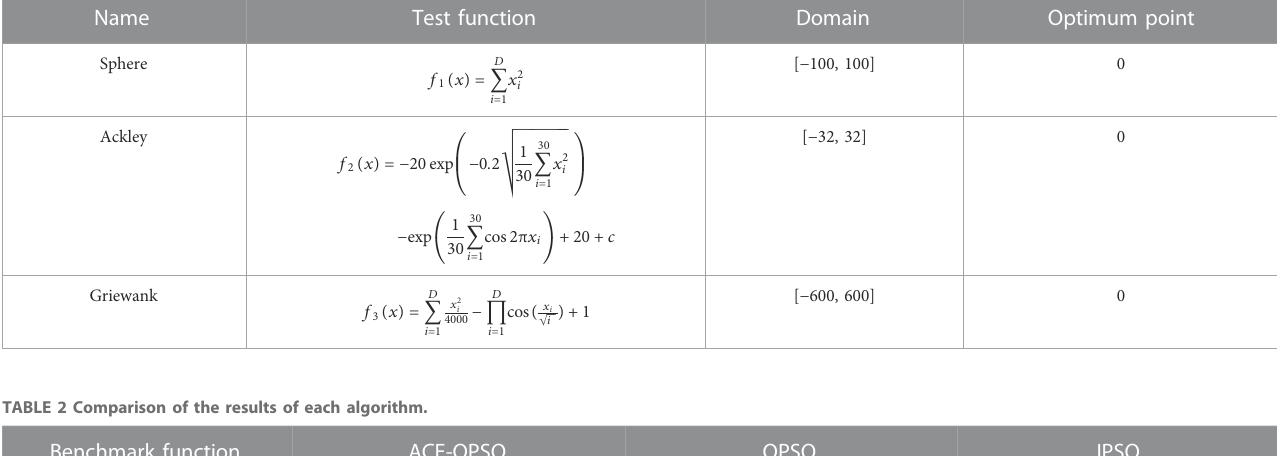
TABLE 1 Three benchmark functions. Name Test function